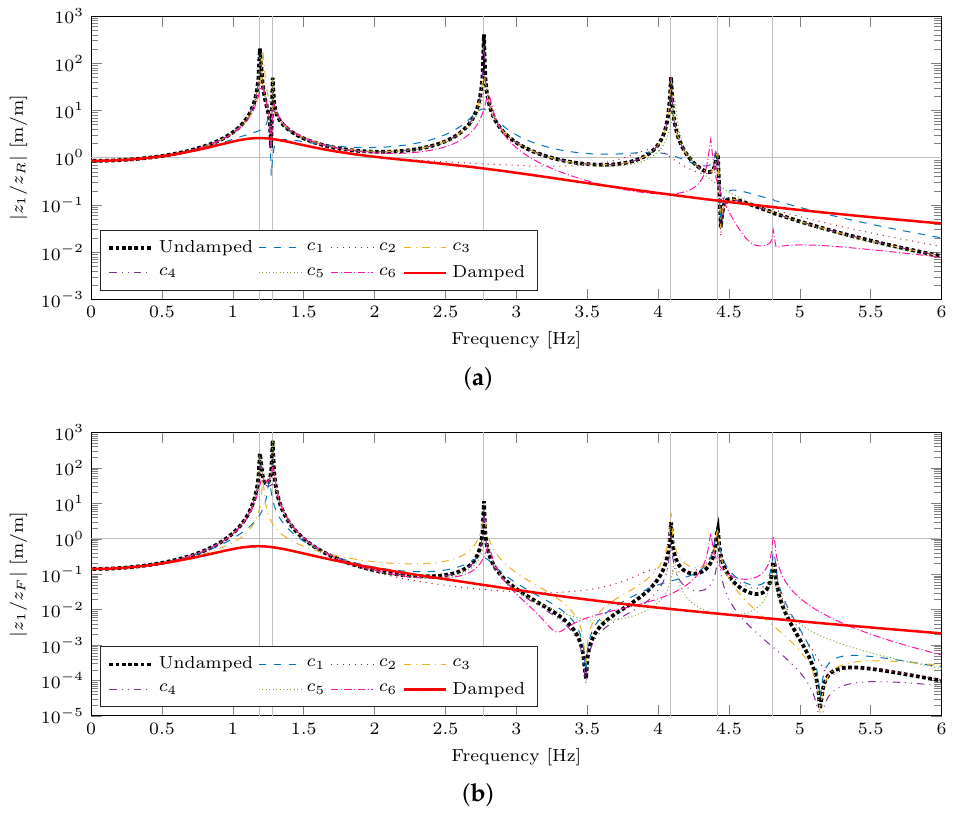
Figure 15. The effects of tractor dampers on the transmissibility between the tractor wheels and the operator’s seat z 1 : ( a ) rear wheels z 1 / z R ; ( b ) front wheels z 1 / z F